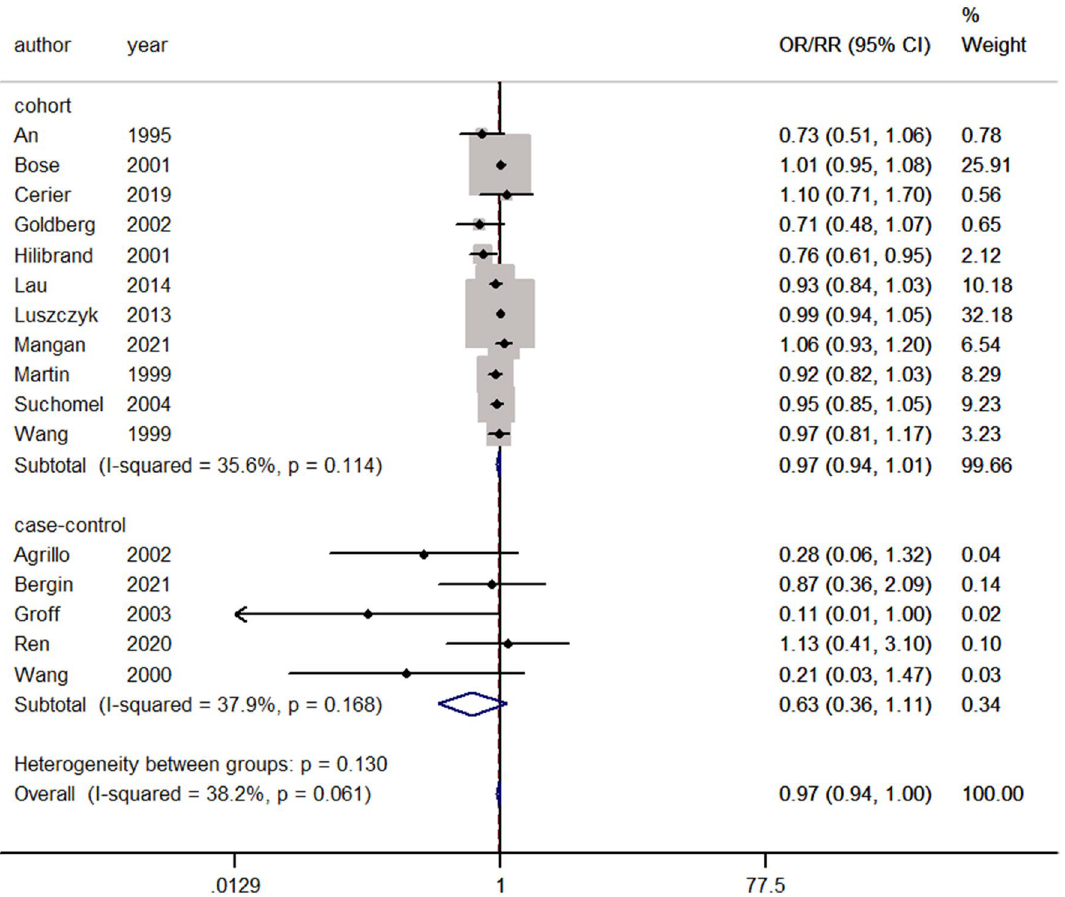
Figure 5. Forest plot showing the effect of smoking on fusion. OR, odd rate; RR, risk rate; CI, confidence observed, and a random-effects model was used (I 2 = 63.7%, p = 0.064). Pooling of the results shows that com- pared with nonsmokers, smokers had no significant correlation with axial neck pain after cervical spine surgery. (ES = 1.54, 95% CI: 0.75–3.16, p = 0.236). After performing sensitivity analysis and removing the study by Liu